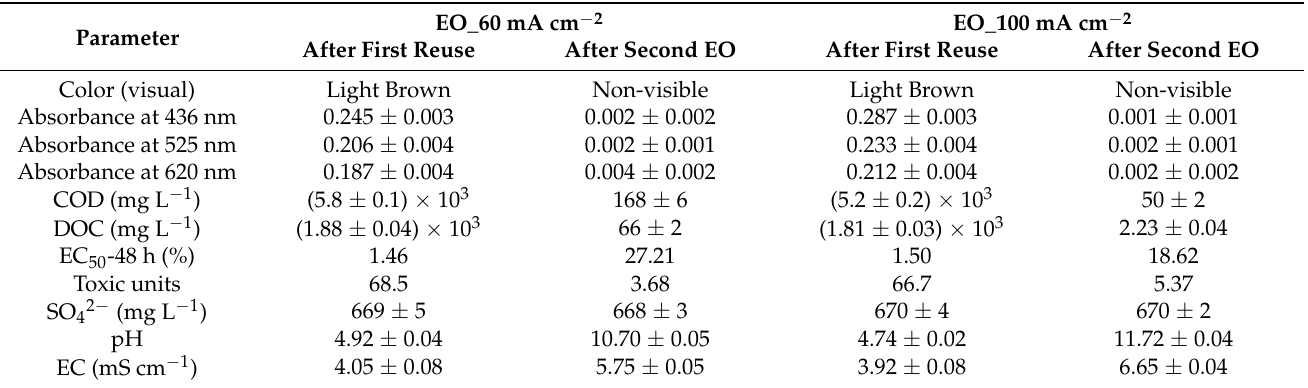
Table 6. Characterization of the TDW samples obtained from the first reuse cycle, before and after the second EO